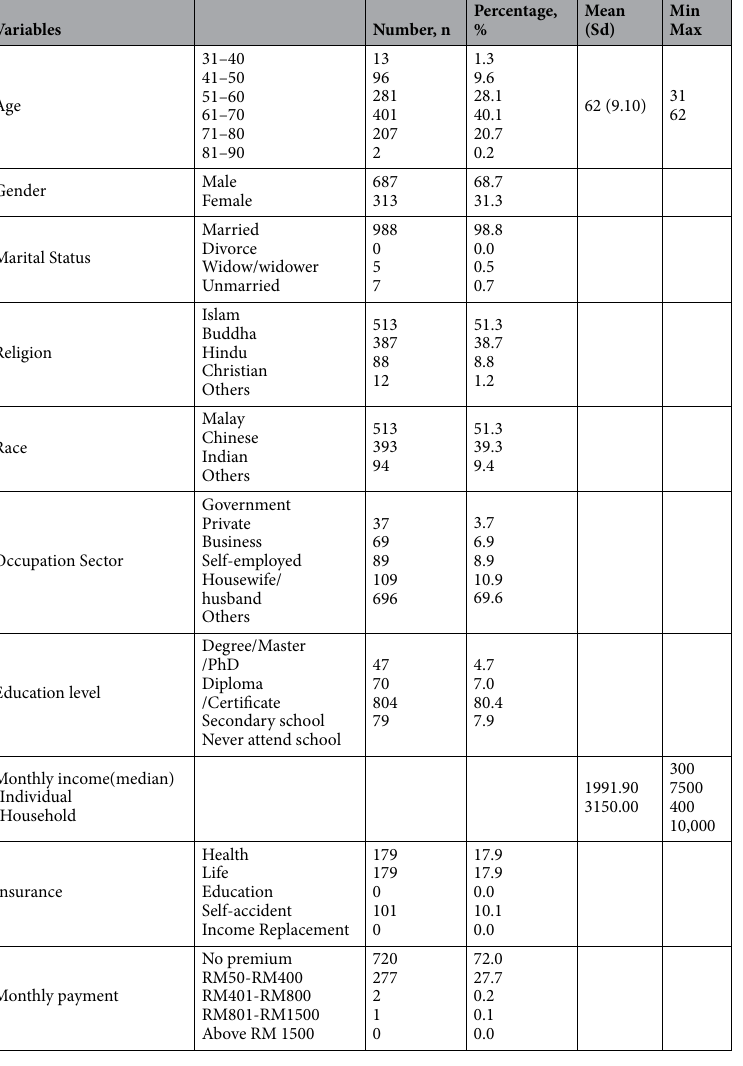
Table 1. Demographic variables and socioeconomic status contributing to CKD. *Mean